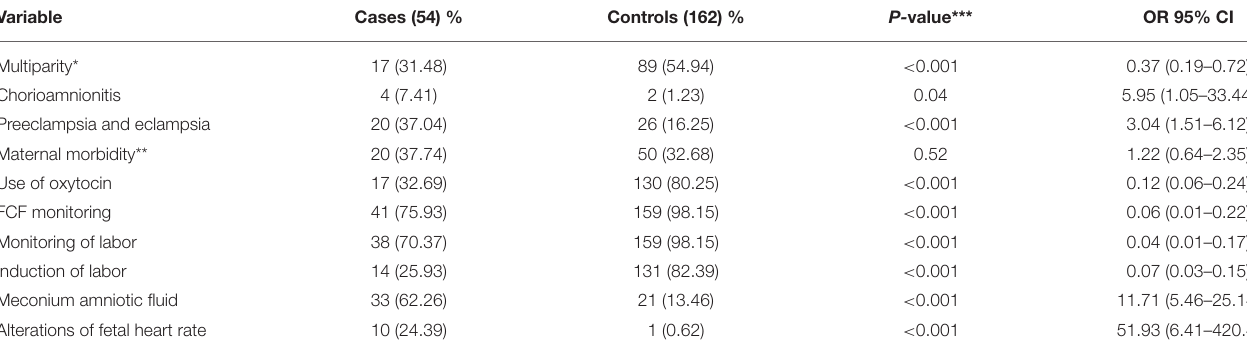
TABLE 3 | Bivariate analysis between perinatal asphyxia and biological variables.